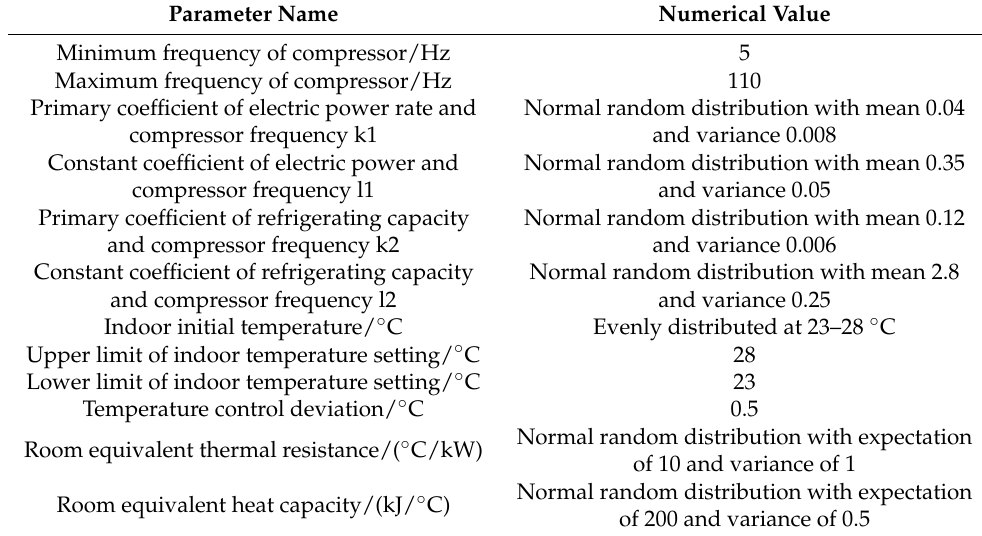
Table 1. Setting of multi-inverter air conditioners and air conditioned room.